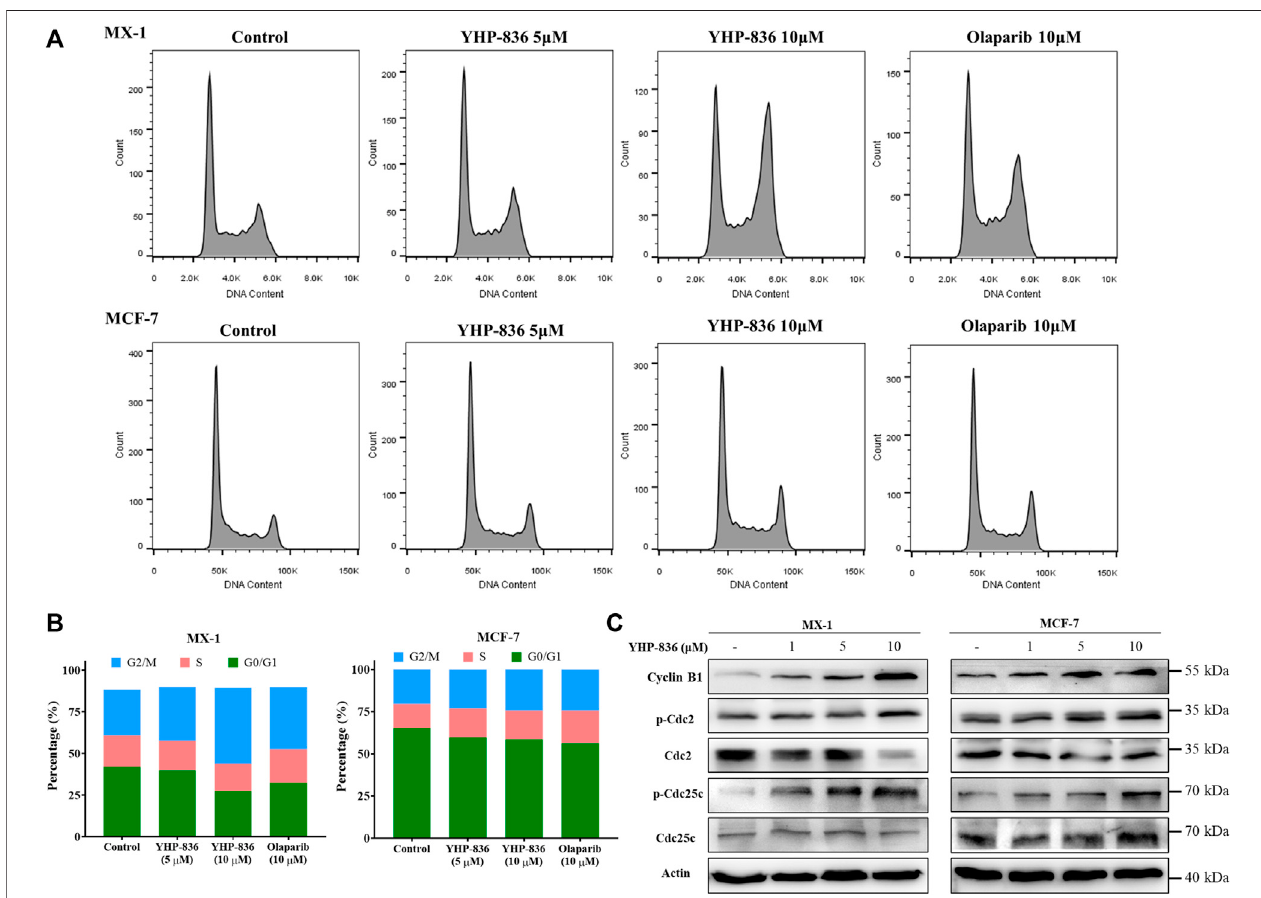
FIGURE 3 | YHP-836 induced cell cycle arrest. (A,B) YHP-836 induced cell cycle arrest in MX-1 and MCF-7 in the G2/M phase. Exposure to YHP-836 at the indicated concentrations (5 and 10 μ M) or olaparib (10 μ M) for 24 h. (C) YHP-836 changed the markers of the G2/M cell cycle. The phosphorylation levels of Cdc2, Cdc25c, and protein level of Cyclin B1 were detected via immunoblotting in both MX-1 and MCF-7 cells exposed to YHP-836 for 24 h.